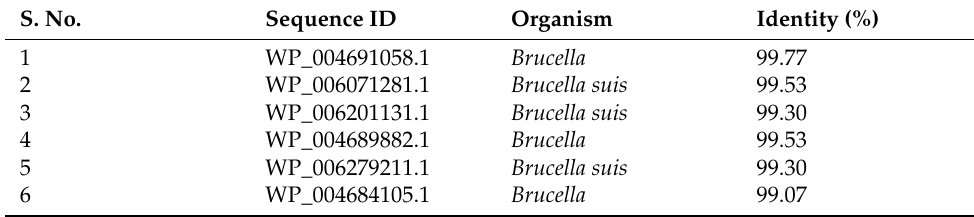
Table 6. Conservancy analysis isocitrate lyase (ICL); (BLASTp results against other B. suis strains). S. No.